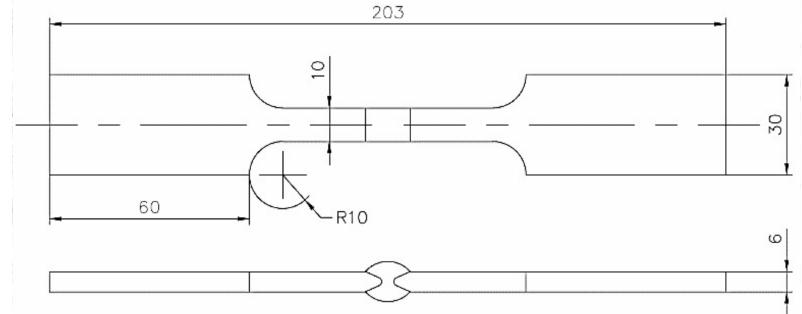
Figure 1. Diagram of tensile and fatigue test specimens (mm).